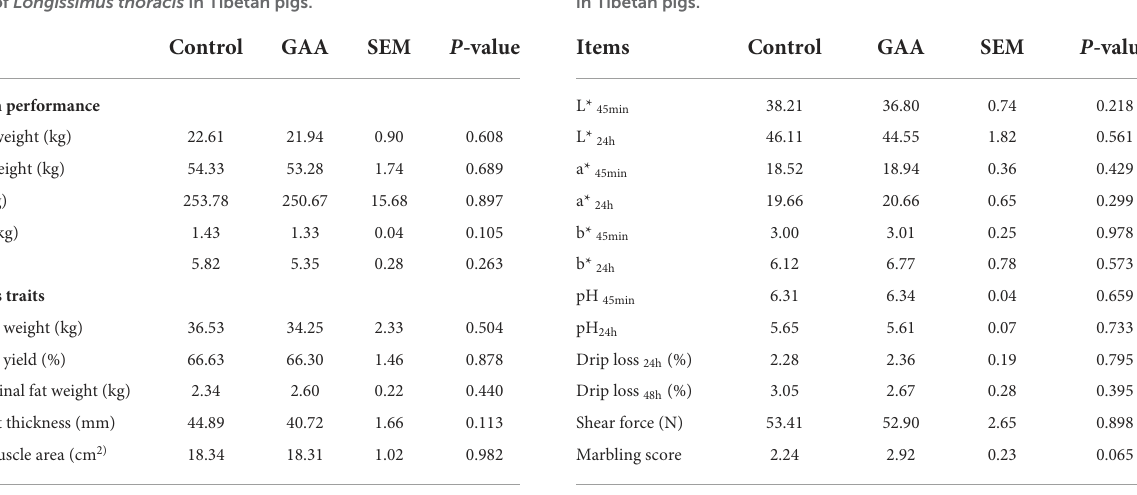
TABLE 1 Effect of dietary GAA on growth performance and carcass traits of Longissimus thoracis in Tibetan pigs.